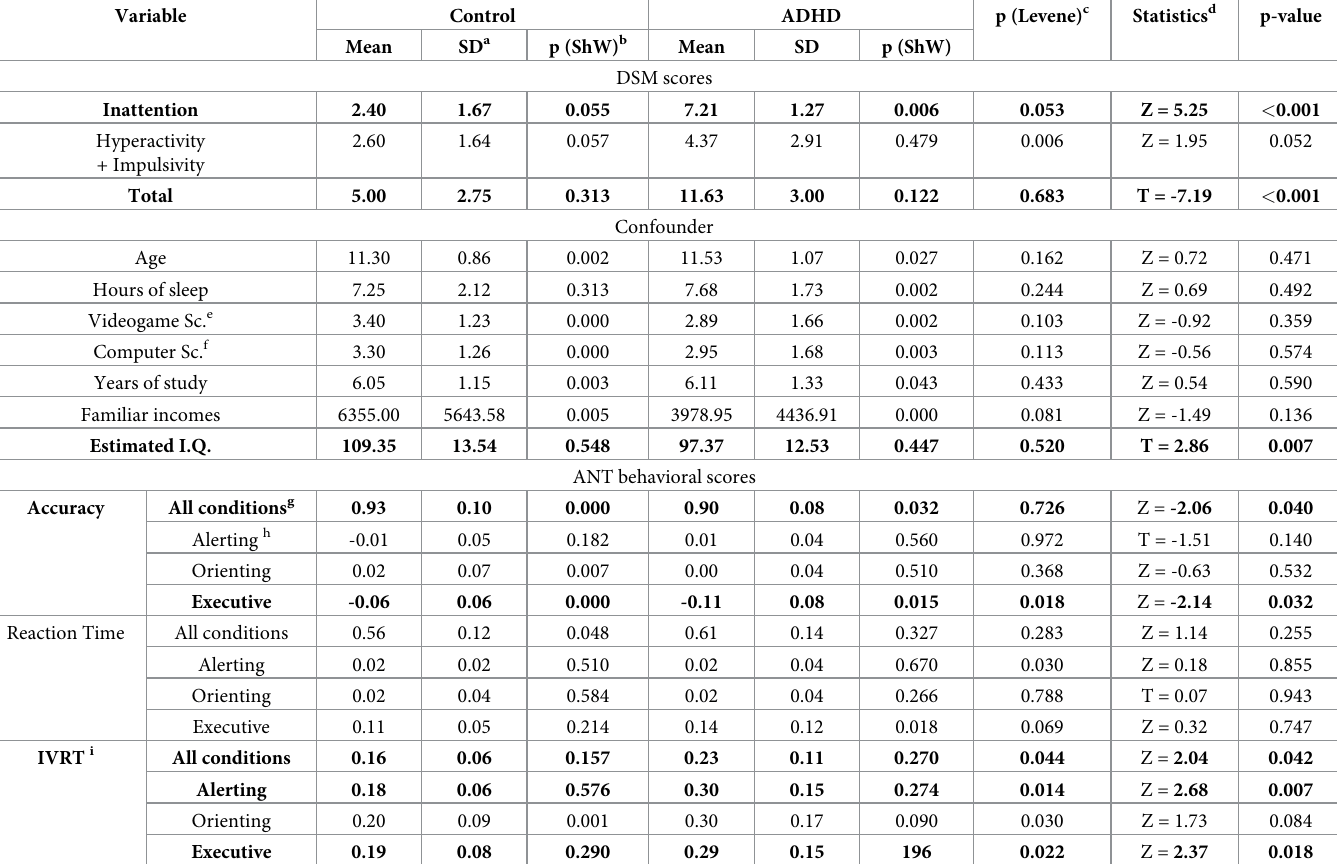
Table 1. Comparisons between groups of DSM scores, confounder variables, and eficiencies of the attention networks.